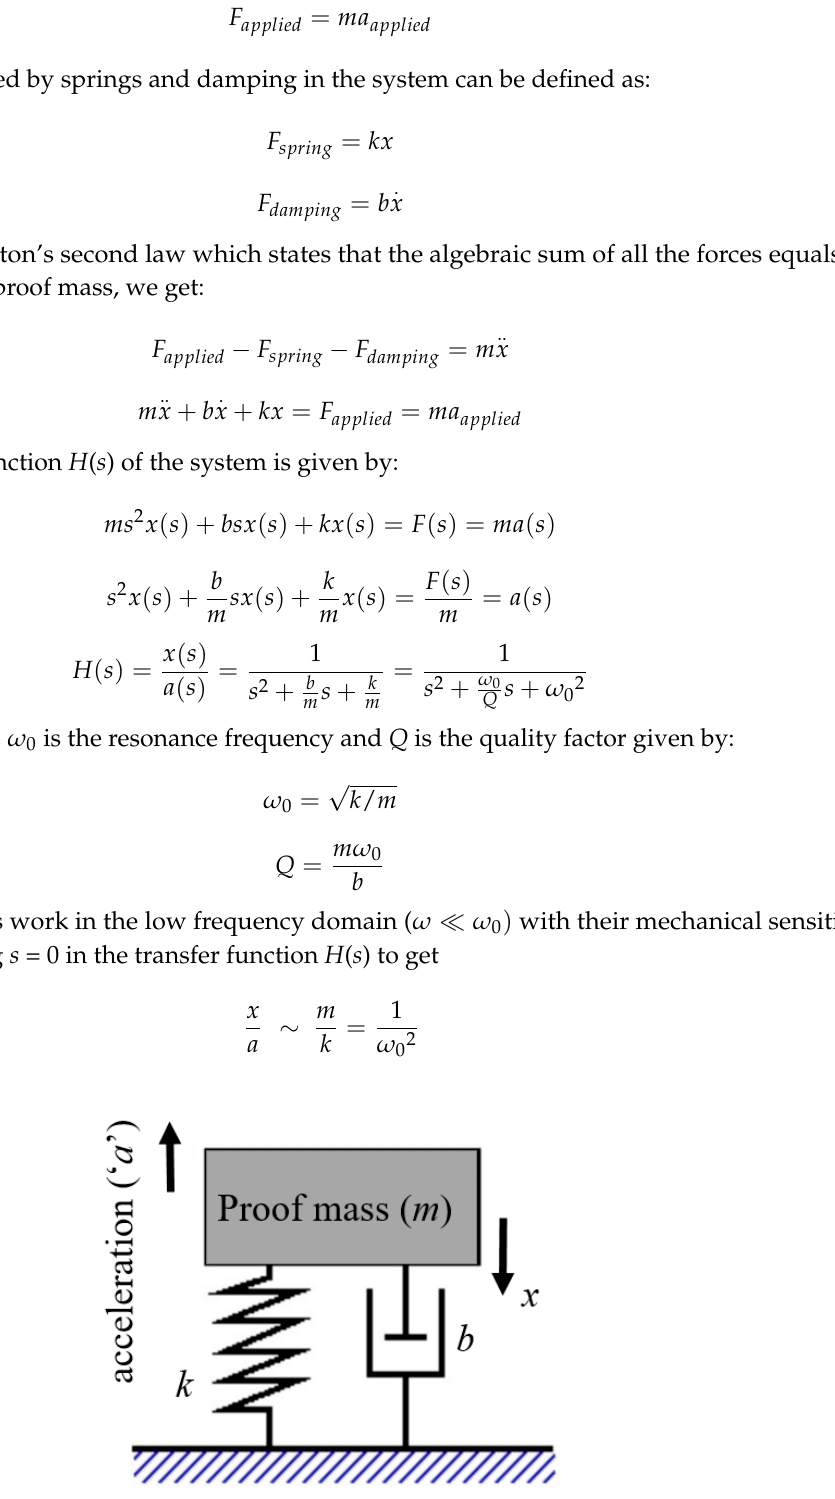
Figure 1. Model of Figure 1. Model of accelerometer.